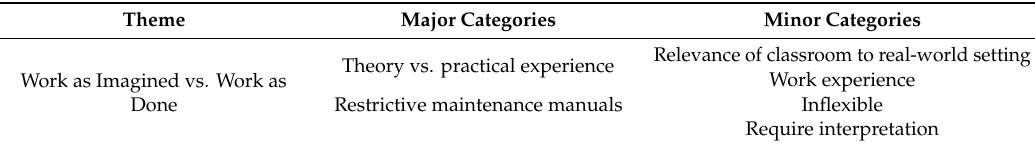
Table 6. Summary of findings for Work as Imagined vs. Work as Done